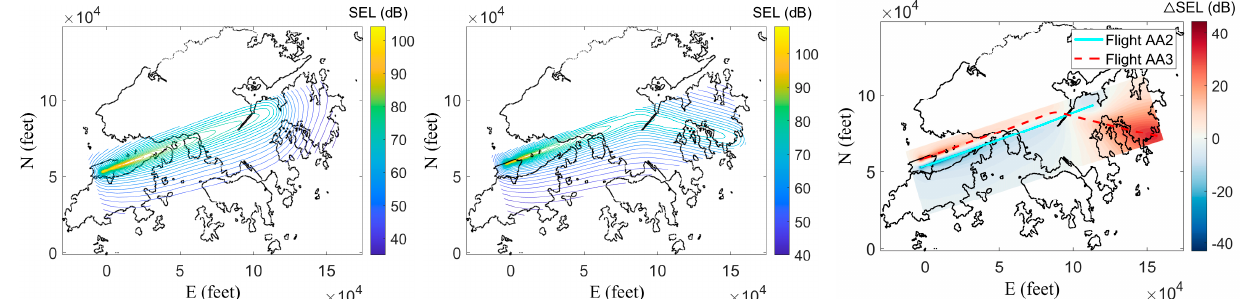
Figure A9. A330 aircraft approaching HKIA. Noise impact (SEL) generated by flight AA2 ( left ) and AA3 ( center ) over Hong Kong city, along with difference ( ∆ SEL) between both results (as obtained by subtracting the former from the latter, right ).